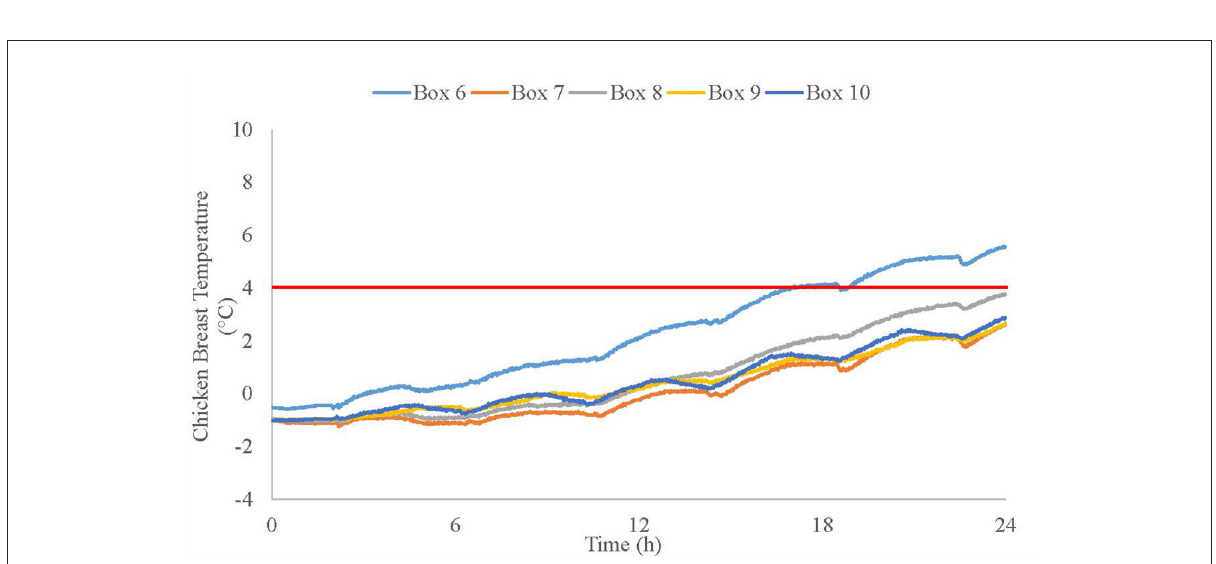
from hottest to coldest: red, orange, yellow, blue, and purple. each layer. In all layers, the centrally placed box is colored purple indicating it was either the least abused box or